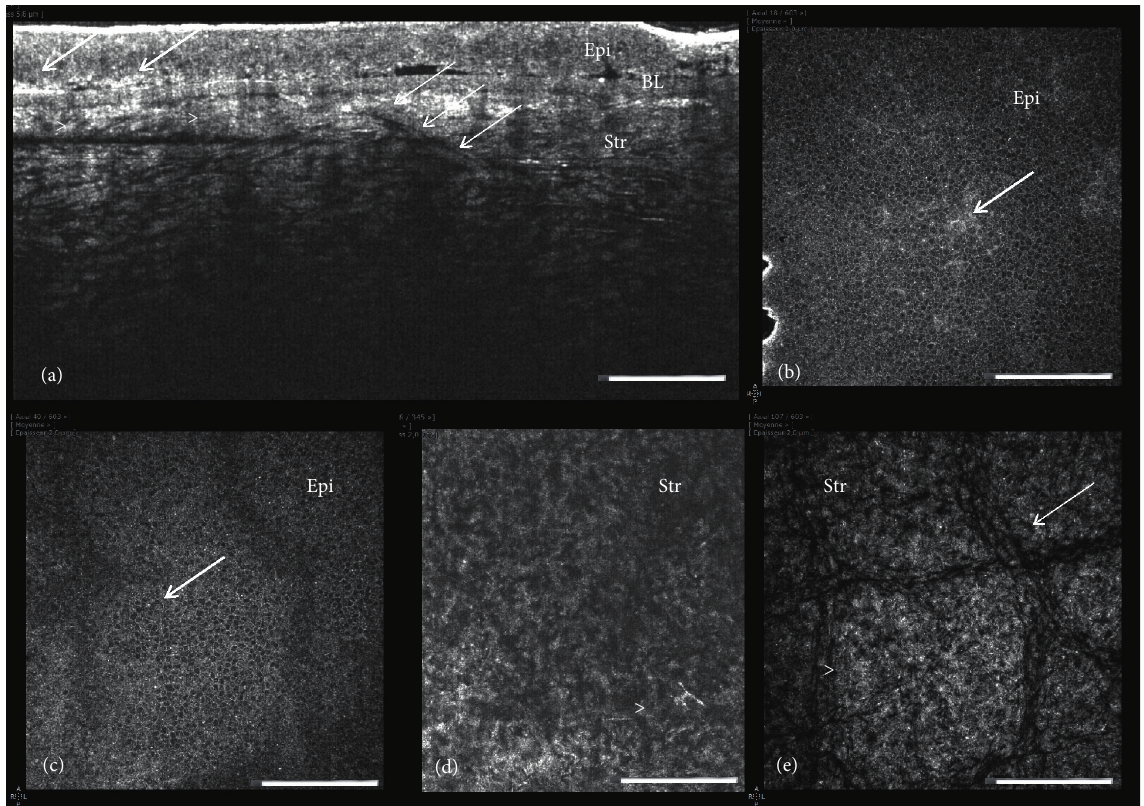
Figure 4: Full field-optical coherence tomography images at different scanning depths showing epithelial and stromal hyperreflective deposits and loss of keratocyte visibility in eyes with Schnyder dystrophy. (a) Cross-sectional reconstruction showing hyperreflective epithelial (arrows) and stromal (arrowheads) deposits and diffuse hyperreflectivity of the anterior stroma. (b-c) en face epithelial images showing epithelial deposit (arrows). Anterior (d) and posterior (e) stroma featuring stromal deposits (arrowheads) and stromal striae (thin arrow) with no visible keratocyte nuclei. Epi, epithelium; BL, Bowman layer; Str, stroma. Bars show 100 μ